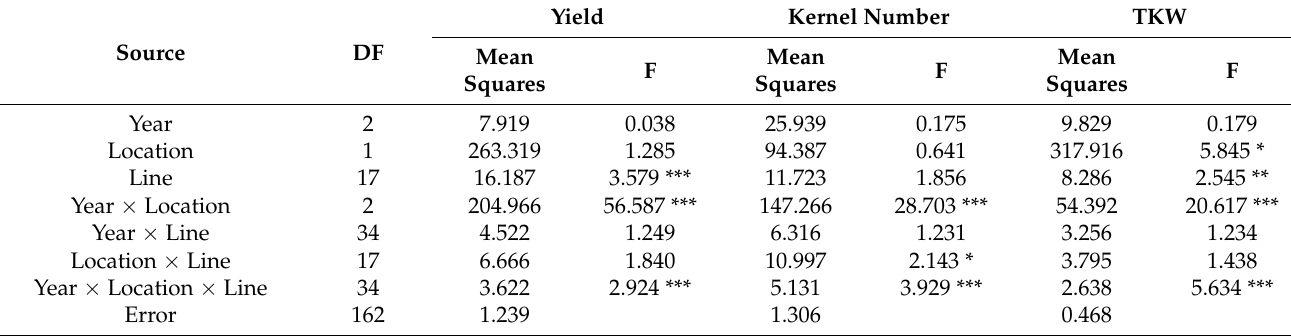
Table 6. Analysis of variance of reductions in yield per head, kernel number in head, and 1000 kernel